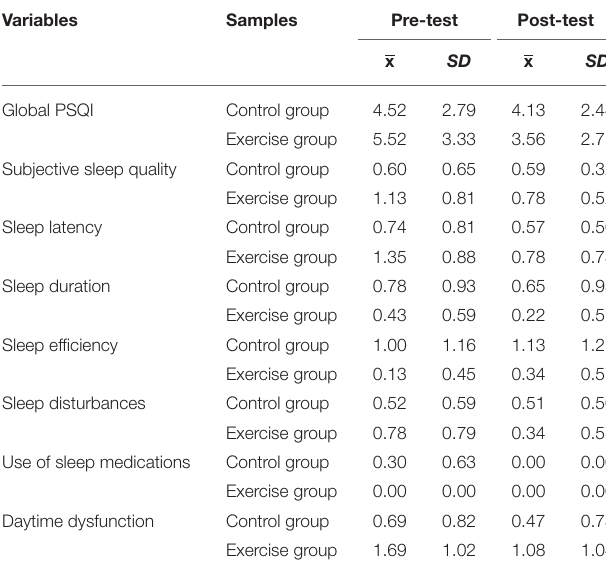
TABLE 4 | Descriptive statistics of sleep quality at pre- and post-test for the total sample and by group. Variables